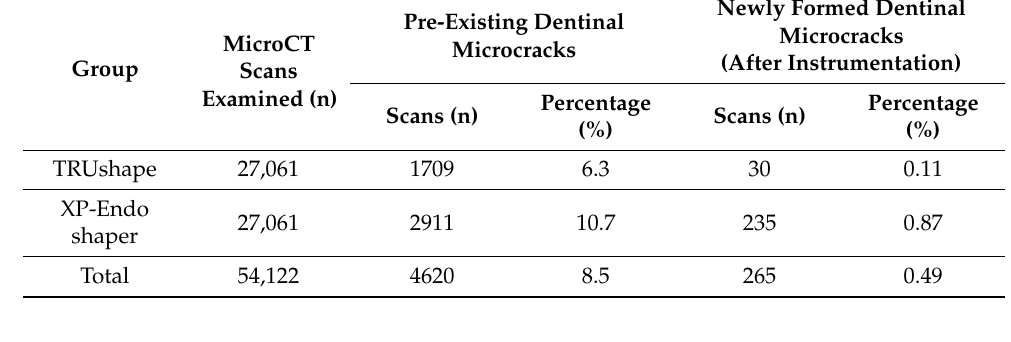
Table 1. Frequency of microcrack formation with TRUshape and XP-Endo Shaper.